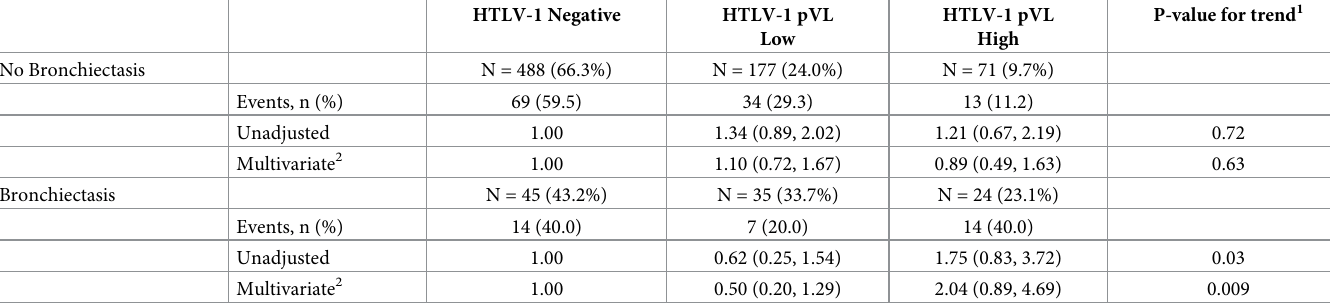
HTLV-1 Negative HTLV-1 pVL